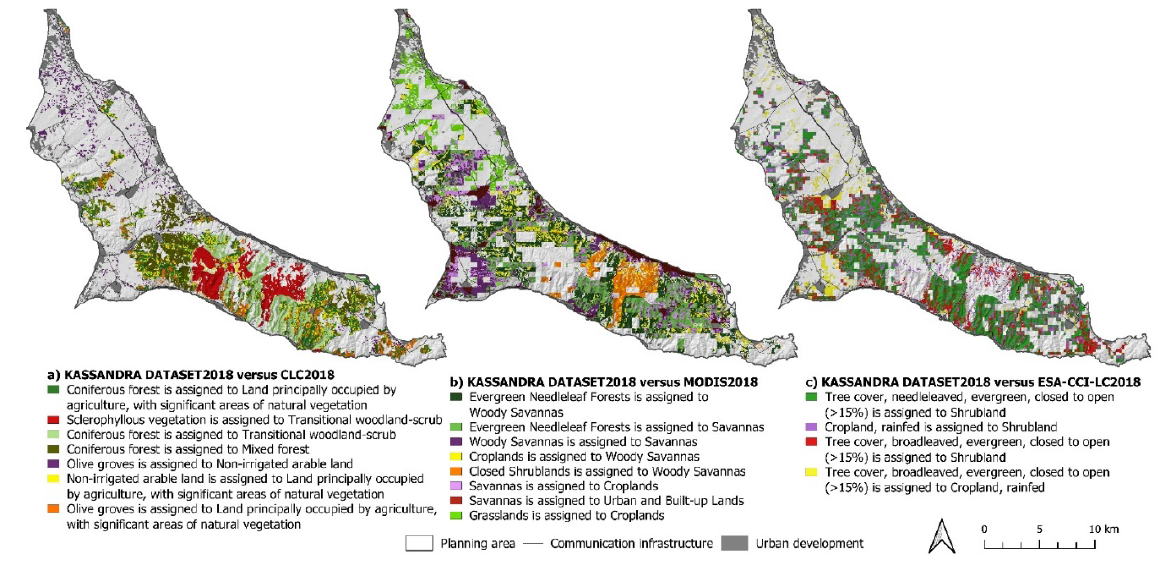
Figure 3. Spatial distribution of dominant land cover differences between the KASSANDRA DATASET2018 and ( a ) CLC2018, ( b ) MODIS2018, and ( c ) ESA-CCI-LC2018 land cover products. Table 4. Areas of dominant land cover differences between the KASSANDRA DATASET2018 and the CLC2018, MODIS2018, and ESA-CCI-LC2018 land cover